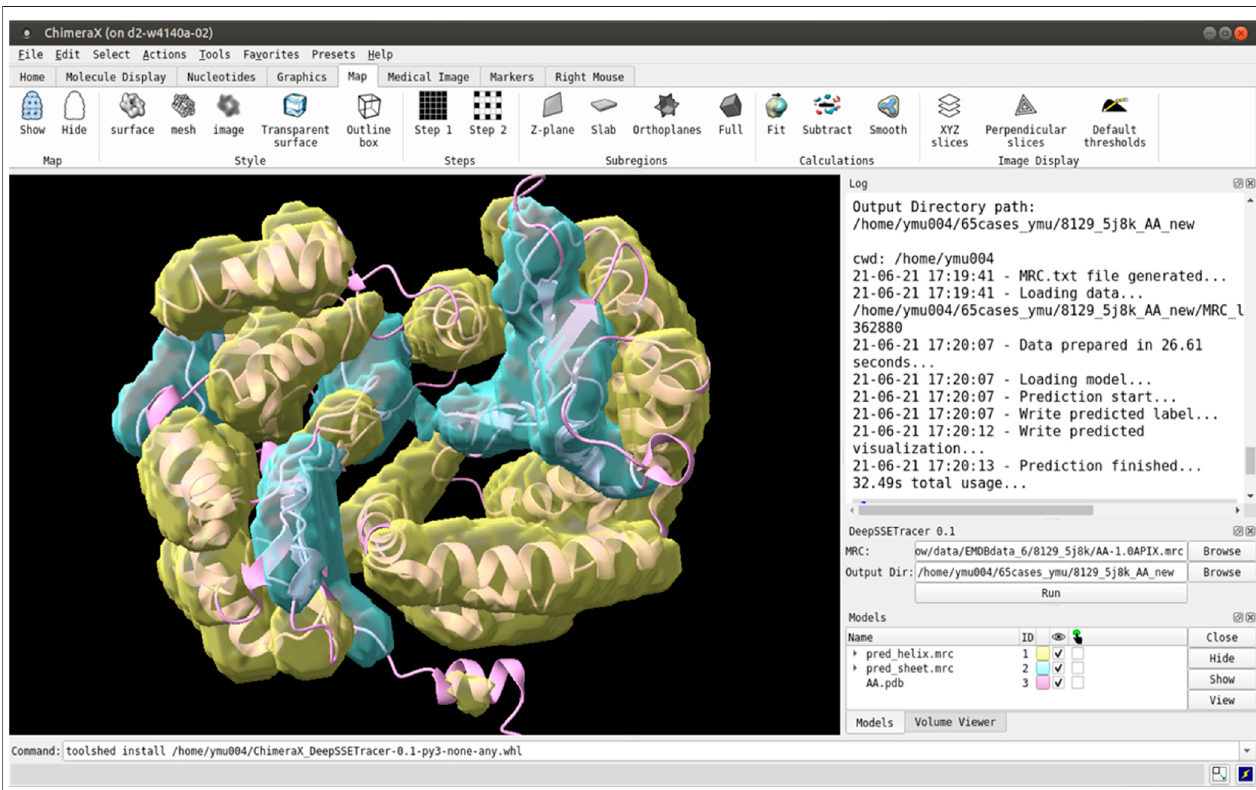
FIGURE 1 | A snapshot of the bundle plugin DeepSSETracer 0.1 installed on ChimeraX. The helix voxels (yellow) and β -sheet voxels (cyan) were detected using DeepSSETracer bundle in ChimeraX.